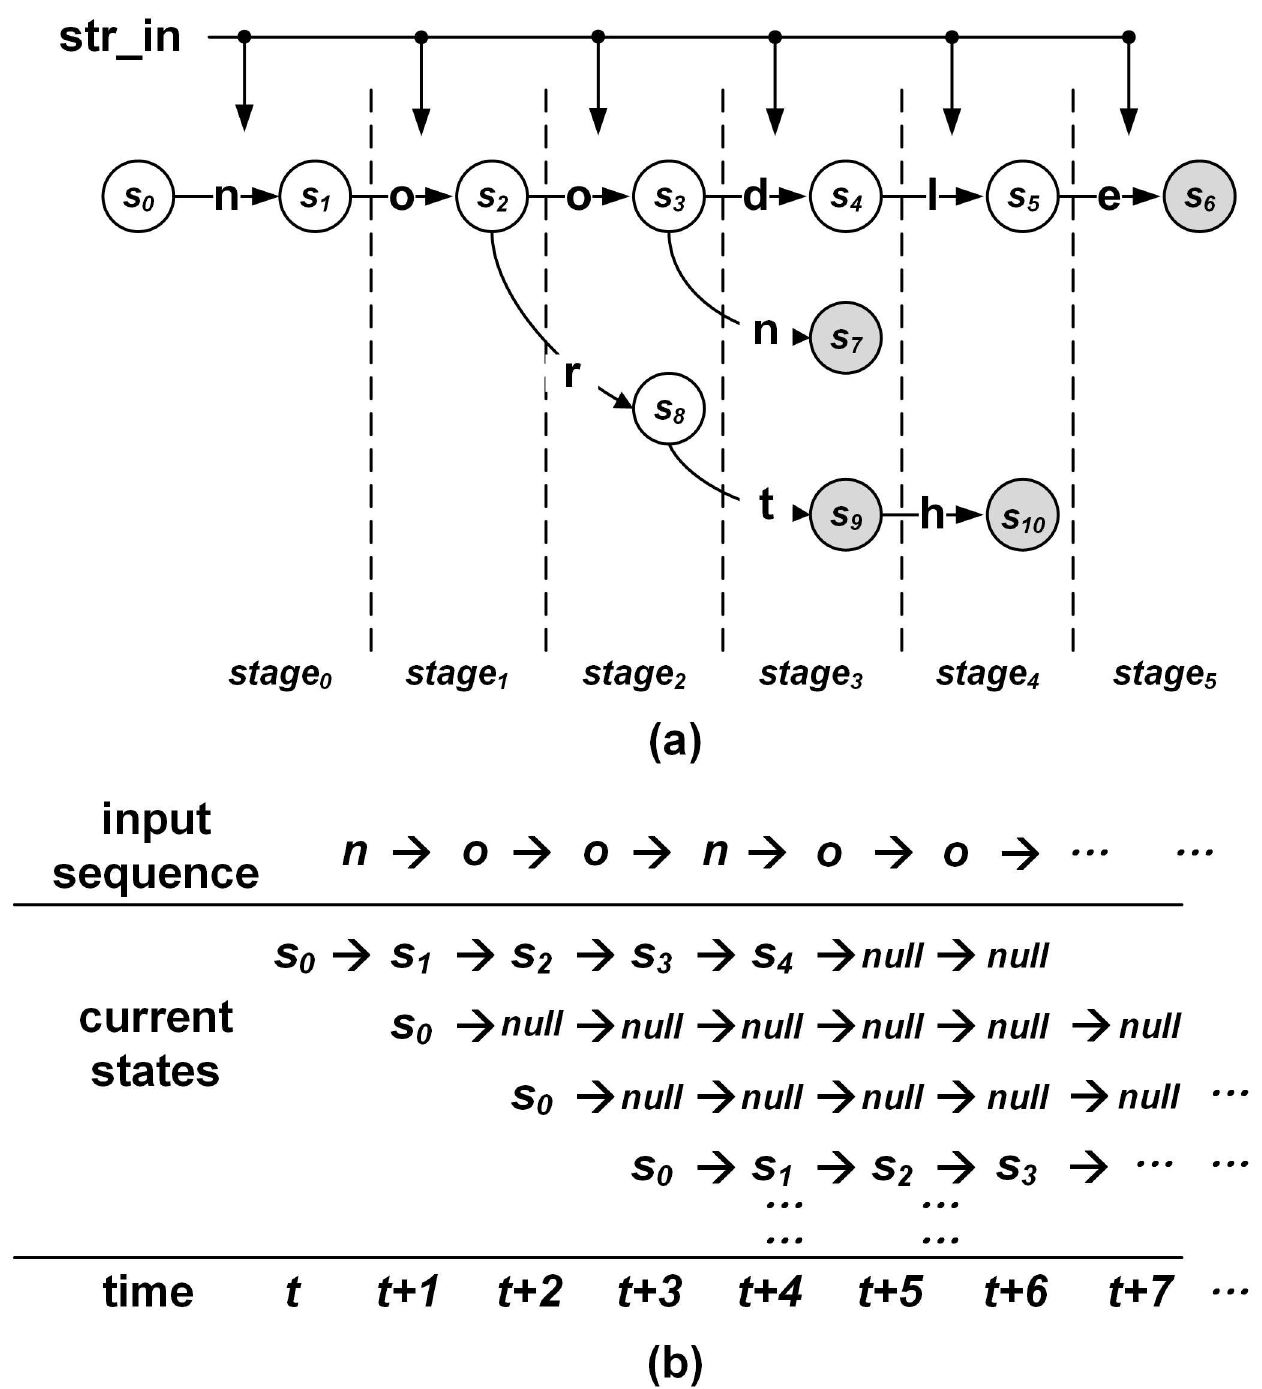
Fig 1. Example of a pipelined NFA: (a) pipelined state transitions for patterns noodle, noon, nort, and north; (b) states in each stage according to an input sequence noonoo .